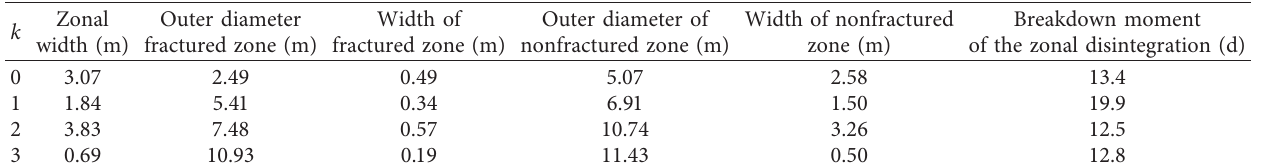
Table 5: Calculation results of zonal disintegration in Qinling water diversion tunnel.